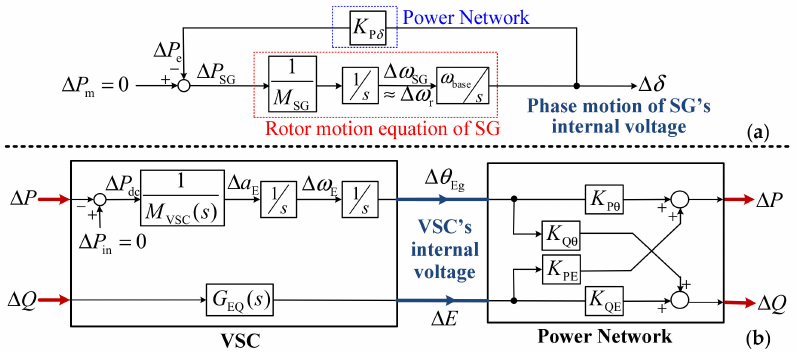
Figure 2. ( a ) Rotor motion equation of a synchronous generator (SG). ( b ) Previous proposed grid-connected VSC system model for stability analysis in DC voltage control (DVC) timescale based on the motion equation concept